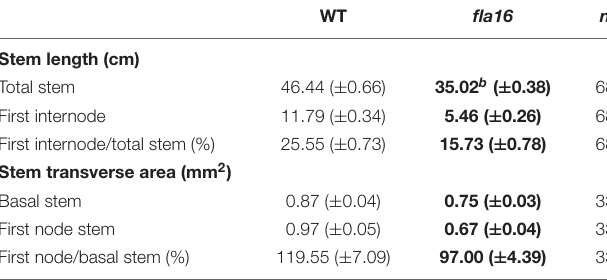
TABLE 1 | Measurement of stem morphology of WT and fla16 stems at maturity a